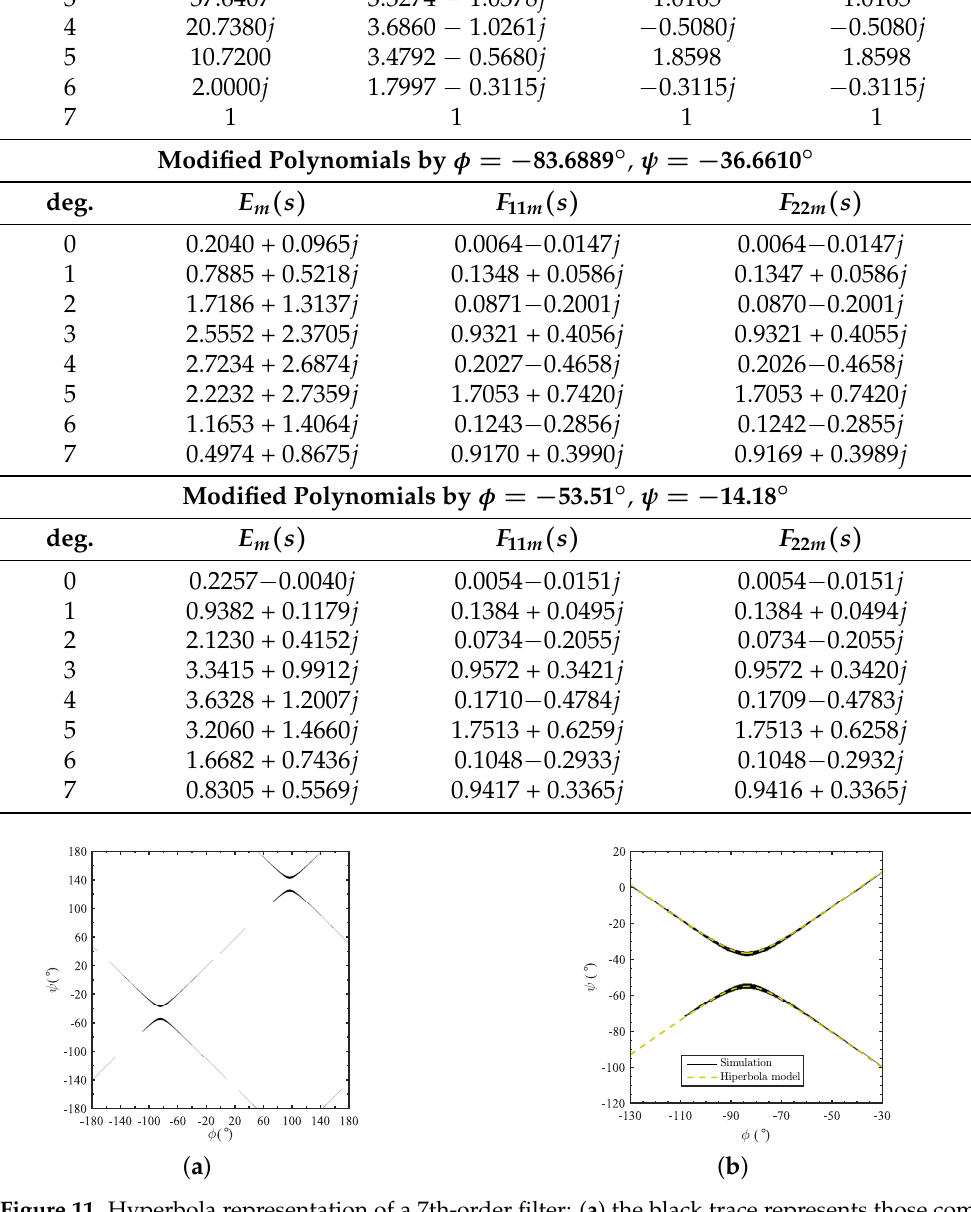
Figure 11. Hyperbola representation of a 7th-order filter: ( a ) the black trace represents those com- binations of ψ , φ that yields | J N + 1 | = 1 and ( b ) a comparison between the modeled and simulated hyperbola. For illustration purpose all | J N + 1 | values that fit in 1 ± 0.001 have been plotted. To characterize the hyperbola, the vertices must be provided. Considering its nature, V h has to be calculated using the expressions in (25). The parabolic steepness parameter p = 6.6294 × 10 3 is obtained using φ = φ 0 + 45 ◦ . Then, the distance from the center to the vertices is α = 9.2096 ◦ . The hyperbola modeled with (15) using the estimated